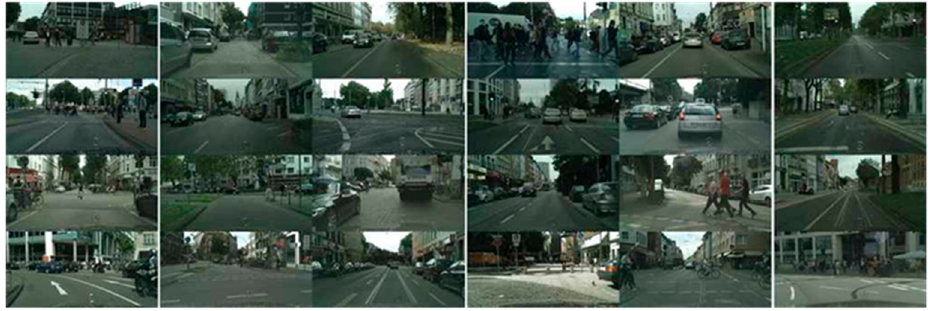
Figure 3. Cityscape database image.